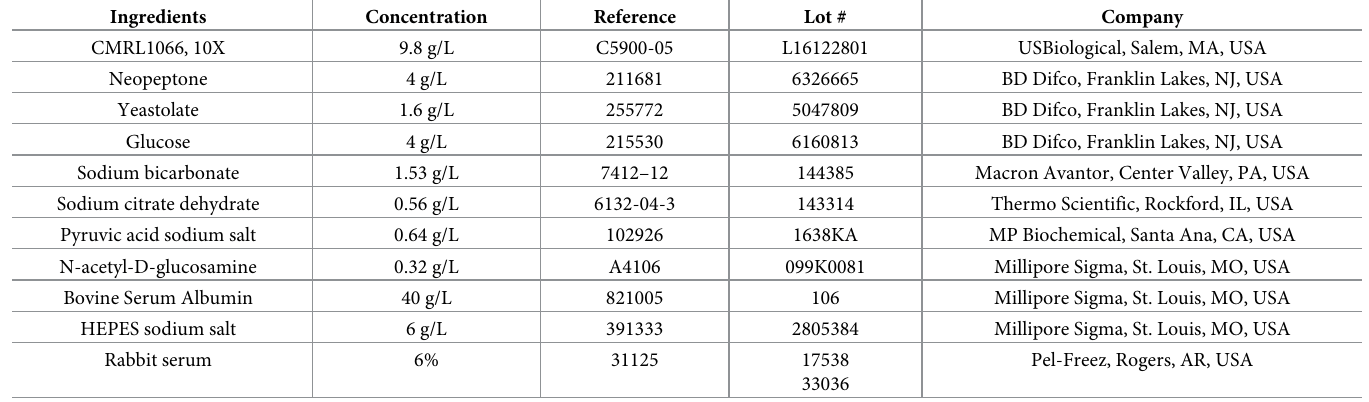
Table 5. BSK-II composition and reference, lot number of each